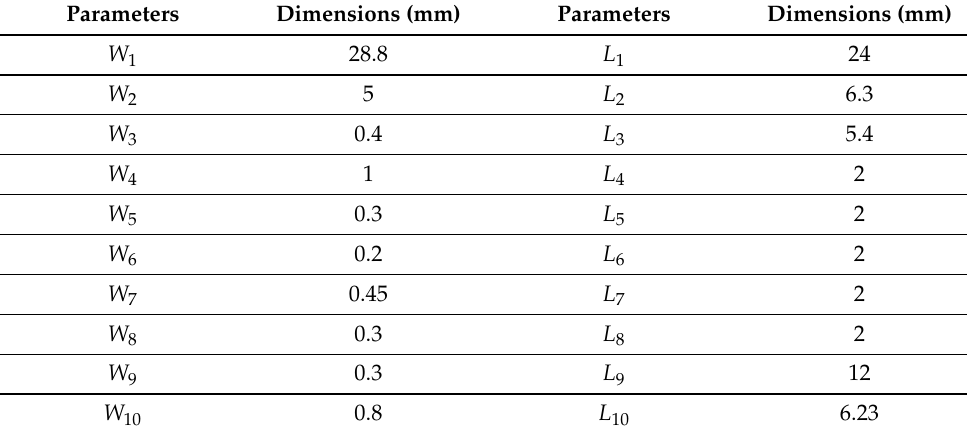
Table 1. 1 × 4 AVA array dimensions.